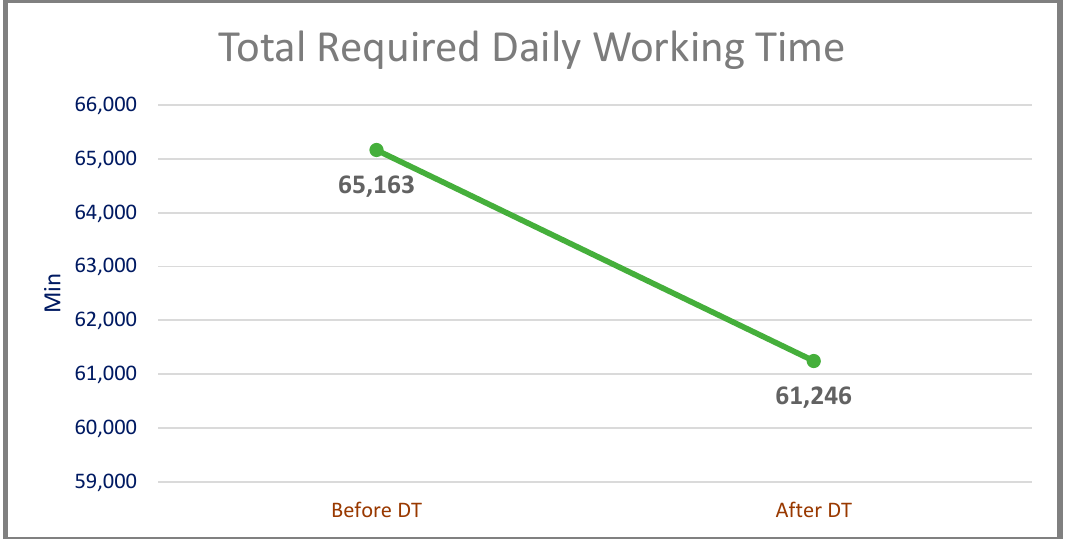
Figure 14. Total daily working time required to do the same amount of work (before and after DT).